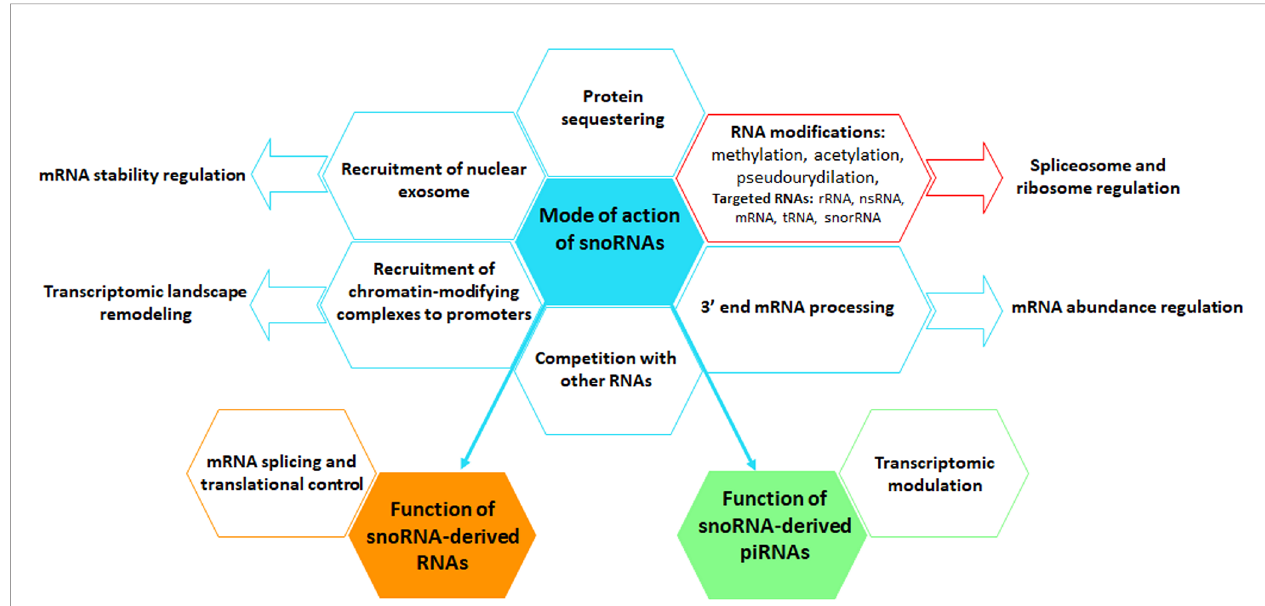
FIGURE 3 | Graphical representation of the mode of action of snoRNAs. snoRNAs perform multiple canonical (red box) and non-canonical (blue boxes) functions, using a broad spectrum of mechanisms, including the regulation of the level and activity of mRNAs and other types of RNAs, protein biogenesis and protein availability. snoRNAs can also be cleaved into snoRNA-derived RNAs, named sdRNAs, that interfere with mRNA splicing and translational processes or into piRNAs, thus regulating the transcriptome. Arrows indicate biological functions that are controlled by